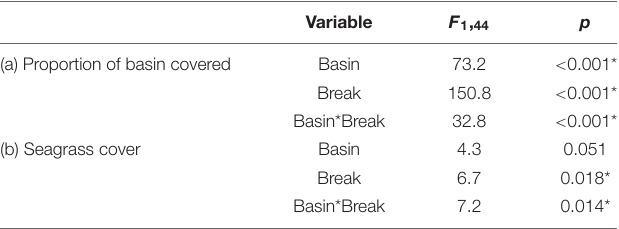
TABLE 4 | Analysis of variance (ANOVA) used to determine significant differences in (a) proportion of basin covered and (b) seagrass cover between basin and before and after the